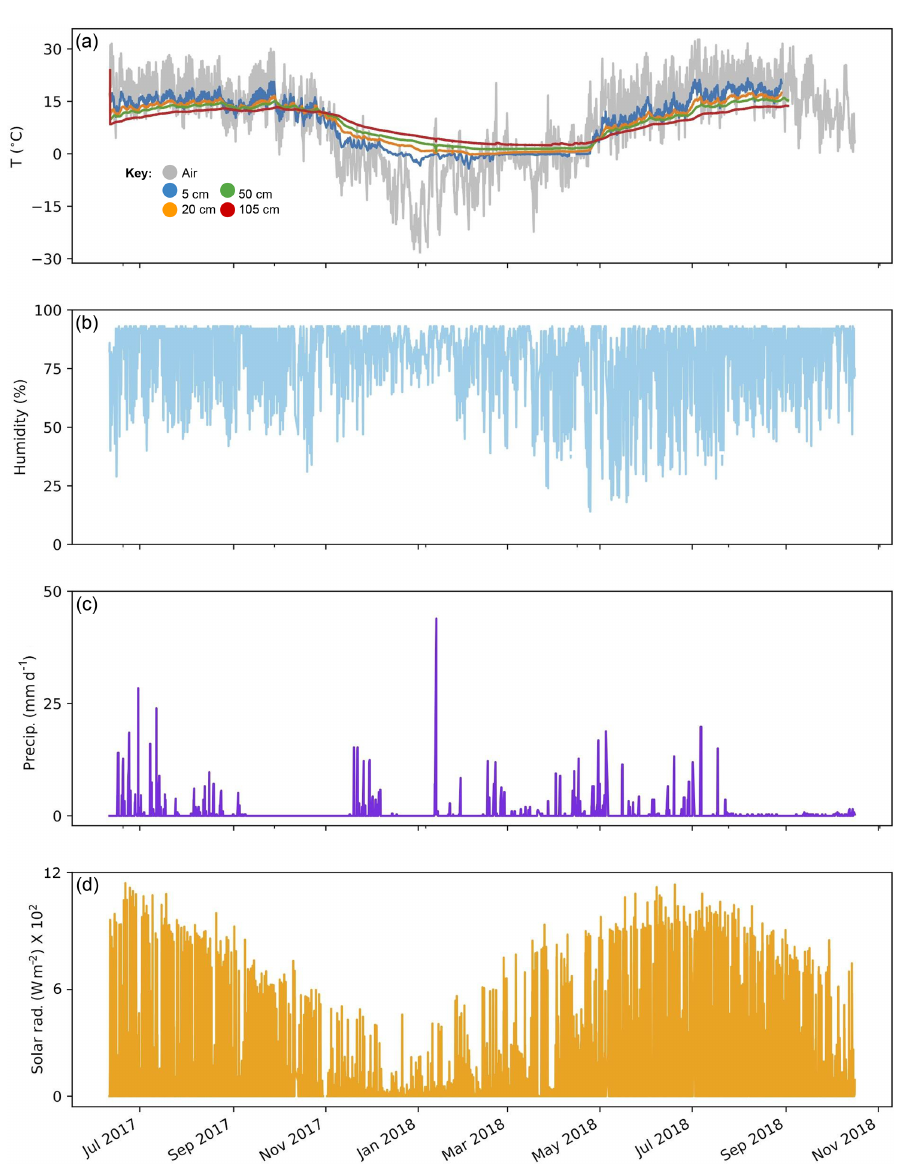
Figure 5. Meteorological conditions and soil temperature between 11 June 2017 and 16 October 2018. Weather conditions were collected by a Davis weather station at the Craftsbury Outdoor Center near Site 2. (a) Air temperature (grey), collected at 30min intervals plotted with ground temperatures. Ground temperatures were collected at 20min intervals adjacent to Site 1 by four HOBO Onset data loggers at depths below the ground surface of 5cm (blue), 10cm (orange), 50cm (green), and 105cm (red). Ground temperature record ends on 2 September 2018. (b) Relative humidity (%). (c) Precipitation (mmd − 1 ). (d) Solar radiation (Wm − 2